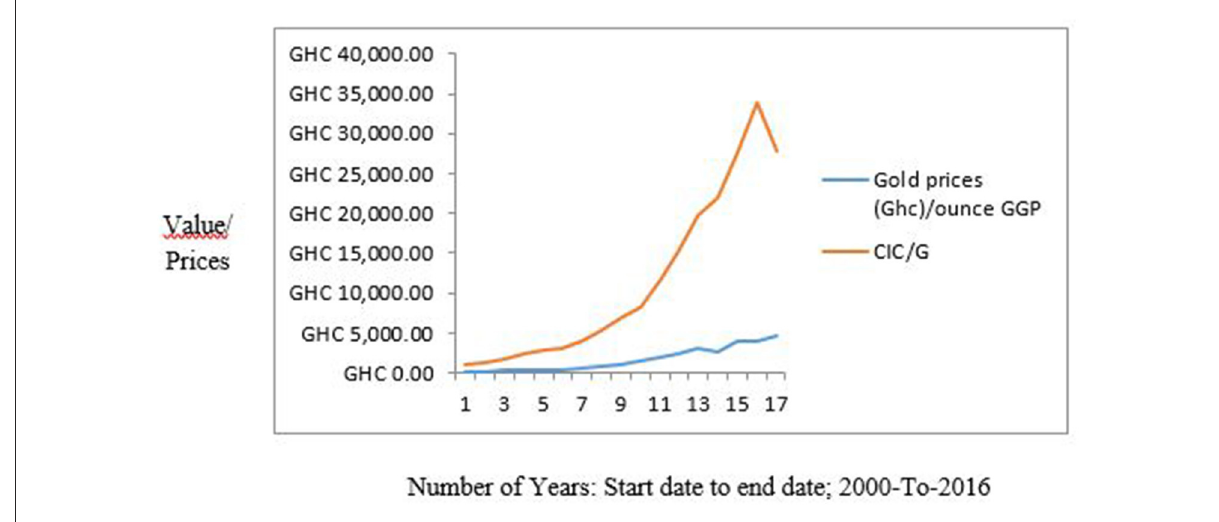
FIGURE2 Average Opportunity cost method of Benchmarking the OPREM model.